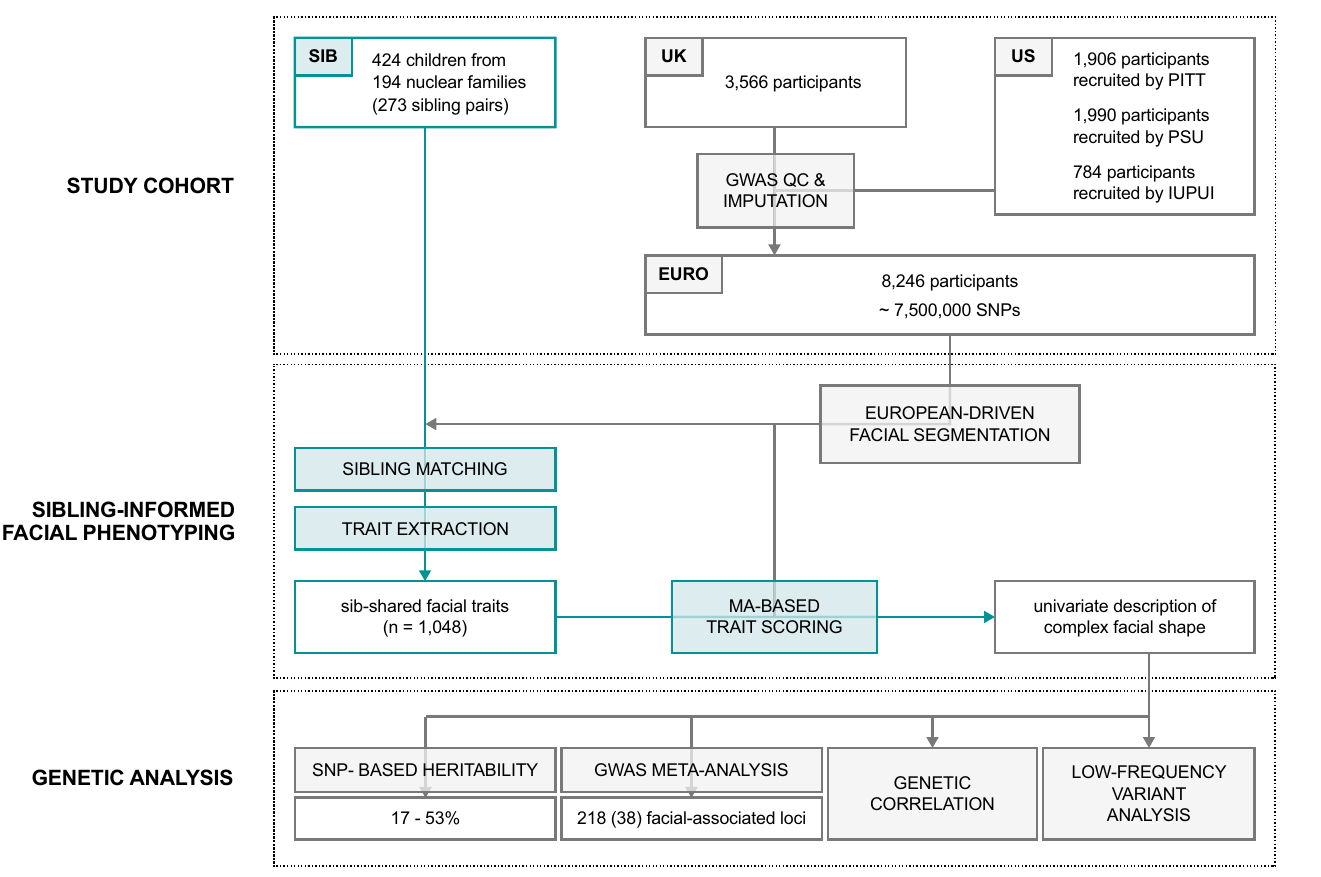
Fig 1. Workflow of the